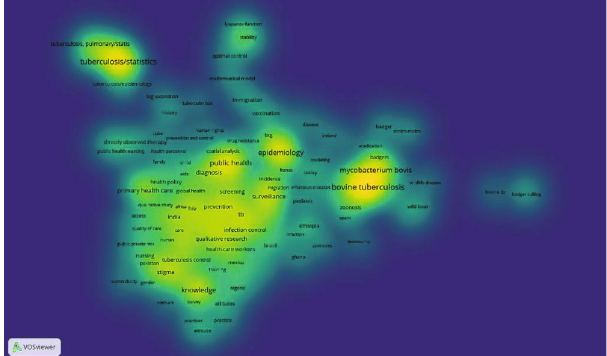
Figure 5: Densities of keywords in the topic “ Prevention ” in scienti fi c articles on